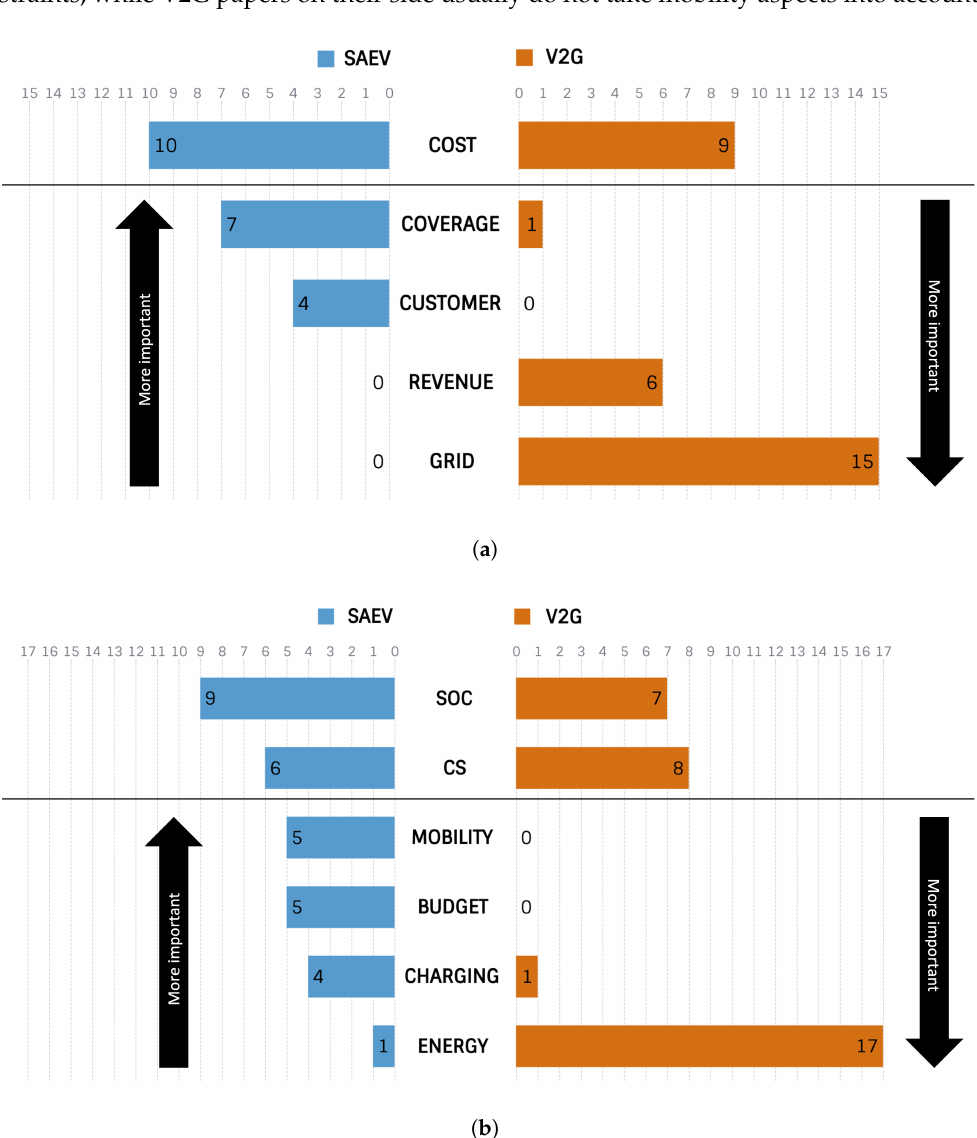
Figure 9. Visualization of the frequency of the usage of ( a ) objective functions and ( b ) constraints in the reviewed SAEV and V2G